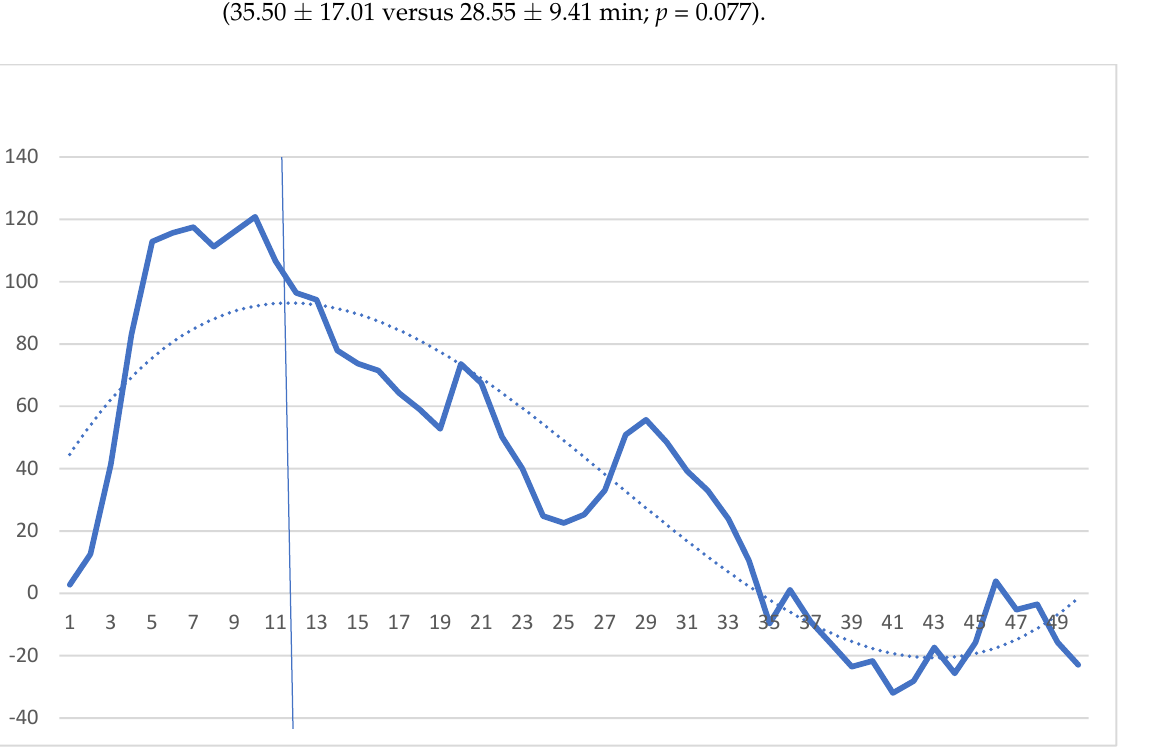
Figure 4. Cumulative sum (CUSUM) analysis of console times for robotic-assisted TAPP inguinal hernia surgery. The x-axis indicates consecutive cases, and the y-axis indicates the CUSUM score for robot console times. The vertical line represents the inflection point that divides between the early and late phases.